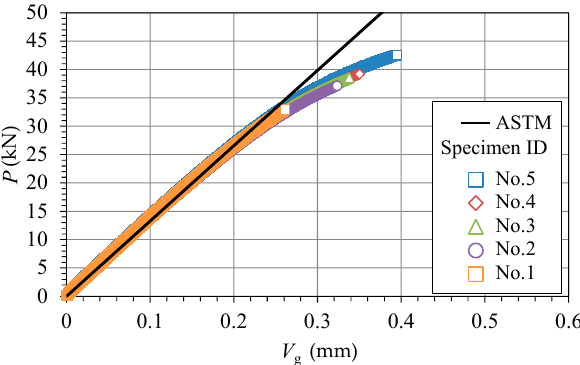
Figure 10. P – V g diagram for case without CRS (S45C, SE(B) specimen, W = 46 mm, B / W = 0.5, − 10 °C). The open symbols represent the experimental results, and the solid line is calculated using Equation (5), which is given in ASTM E1820.